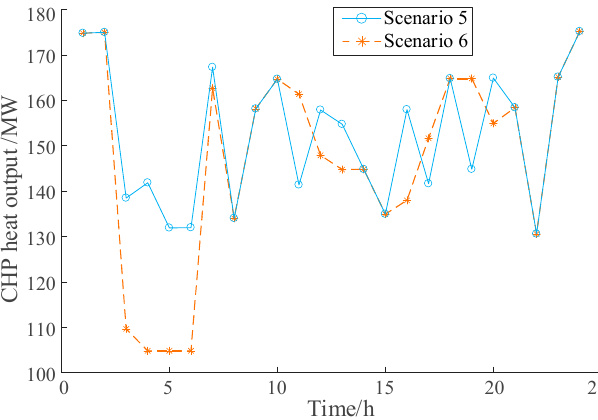
Figure 8. CHP heat output of Scenarios 5 and 6.